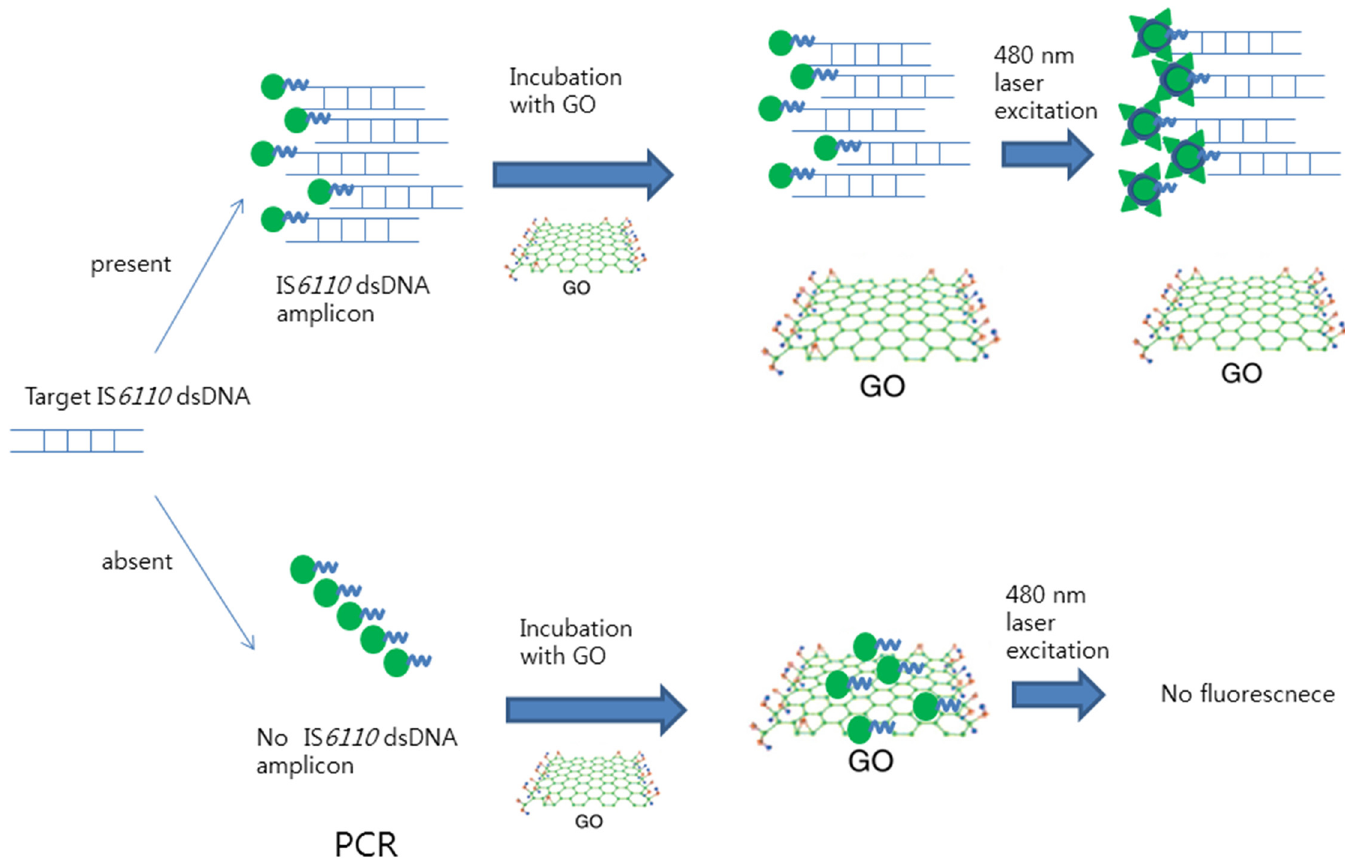
Fig 1. Illustration describing the GO-based sensing system for homogenous detection of the IS 6110 DNA amplicon. In the presence of the IS 6110 DNA amplicon, the fluorescent dye-labeled primers are incorporated into the amplicon causing the primers to separate from GO, leading to increased fluorescence (upper part of the figure). In the absence of the target DNA, the fluorescent dye-labeled primers remain adsorbed to the GO layer, resulting in fluorescence quenching (lower part of the